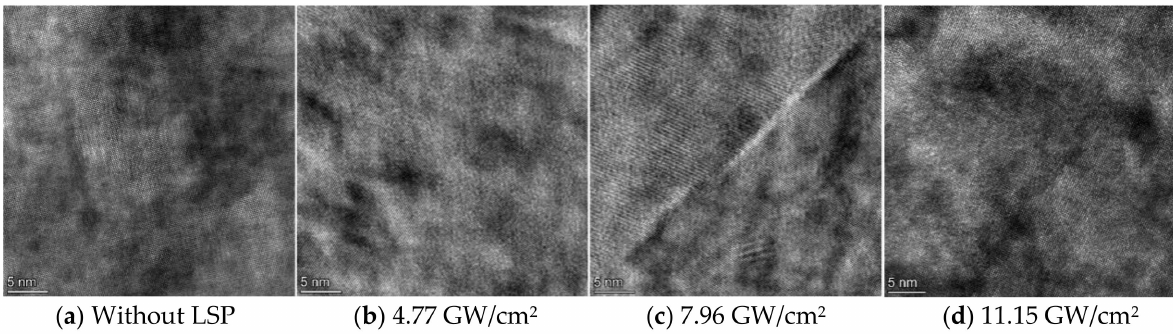
Figure 8. HRTEM images of the laser NV E690 cladding layer without and after LSP at various laser power